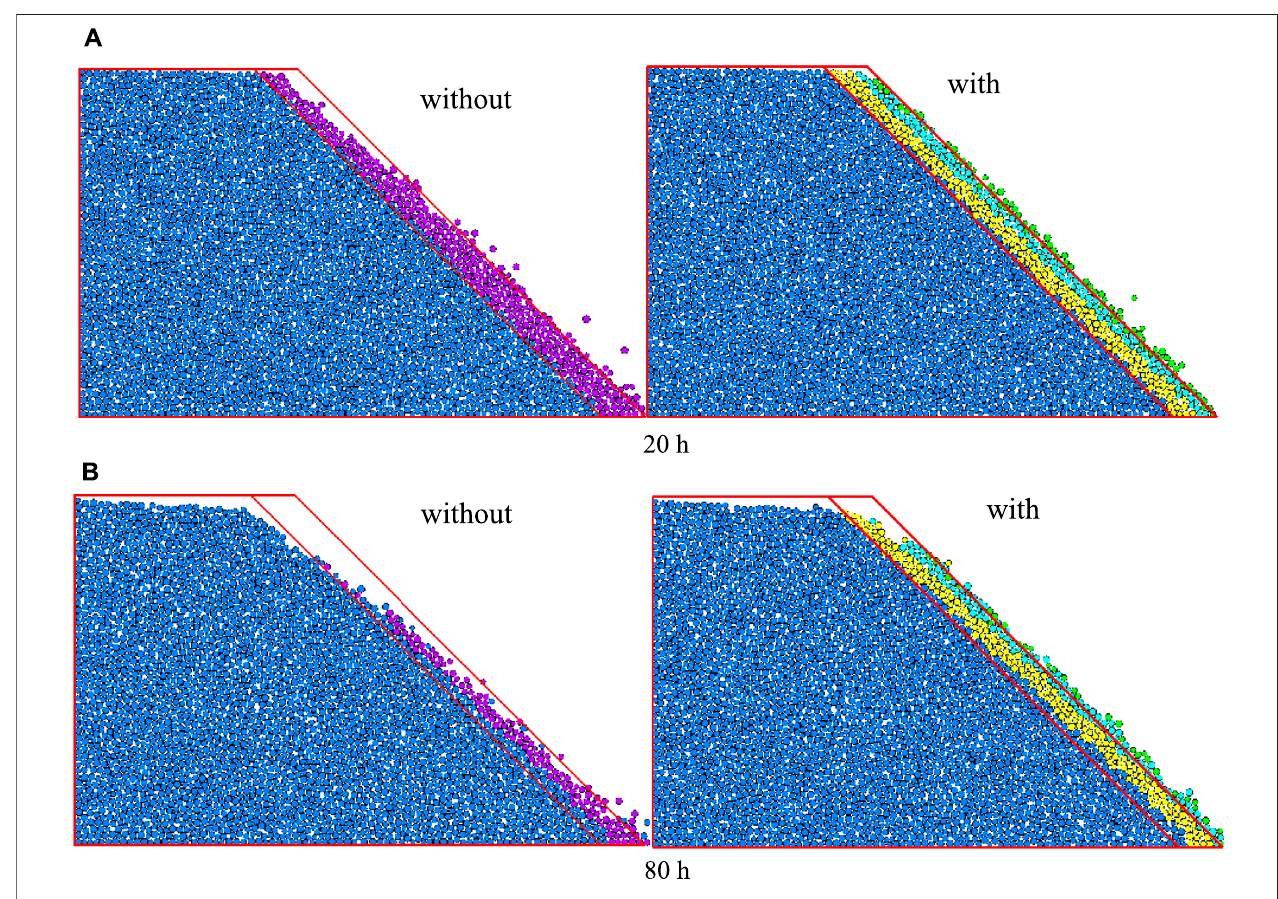
FIGURE 14 | Comparison of erosion failure mechanisms without and with composite slope protection at. (A) 20 h and (B) 80 h